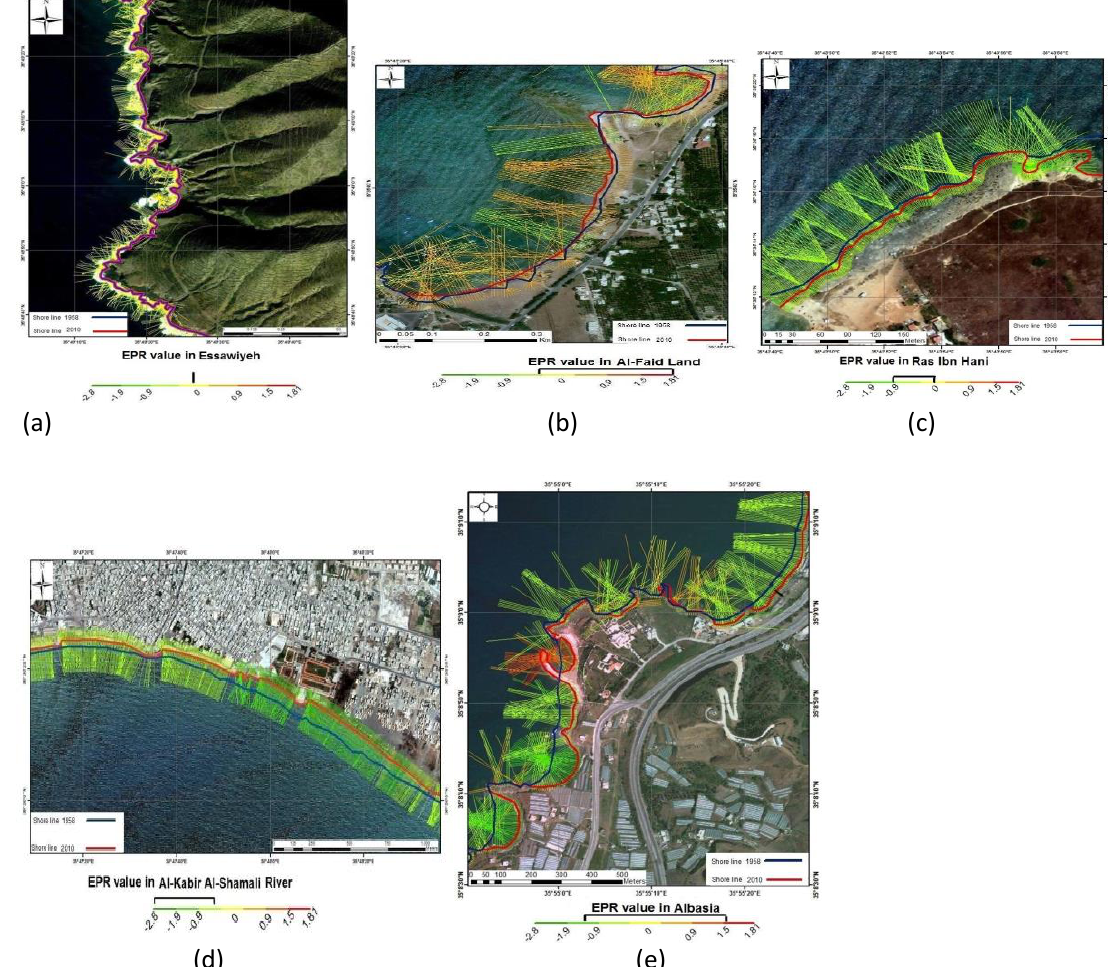
Figure 2: (a) The value of EPR in Al Issawiyah area Depending on the DSAS tool, (b) the value of EPR in Al faid land area Depending on the DSAS tool, (c) The value of EPR in Ibn Hani area Depending on the DSAS tool, (d) the value of EPR, In Al-kabir al-shamali river Depending on the tool DSAS, (e) the value of EPR in the Albasia area depending on the DSAS